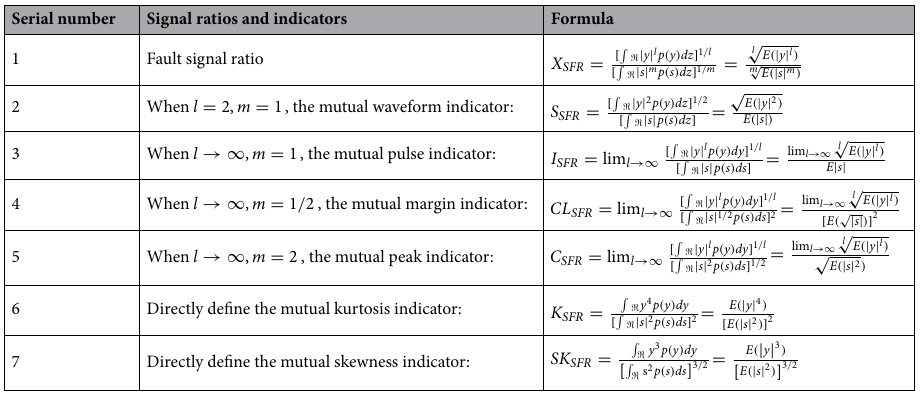
Table 1. Mutually dimensionless indicator